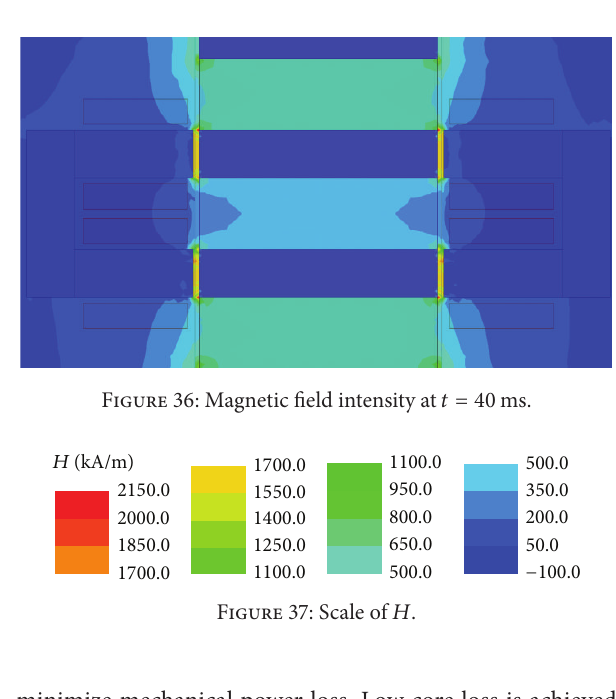
Figure 35: Magnetic field intensity at 𝑡 = 30 ms.